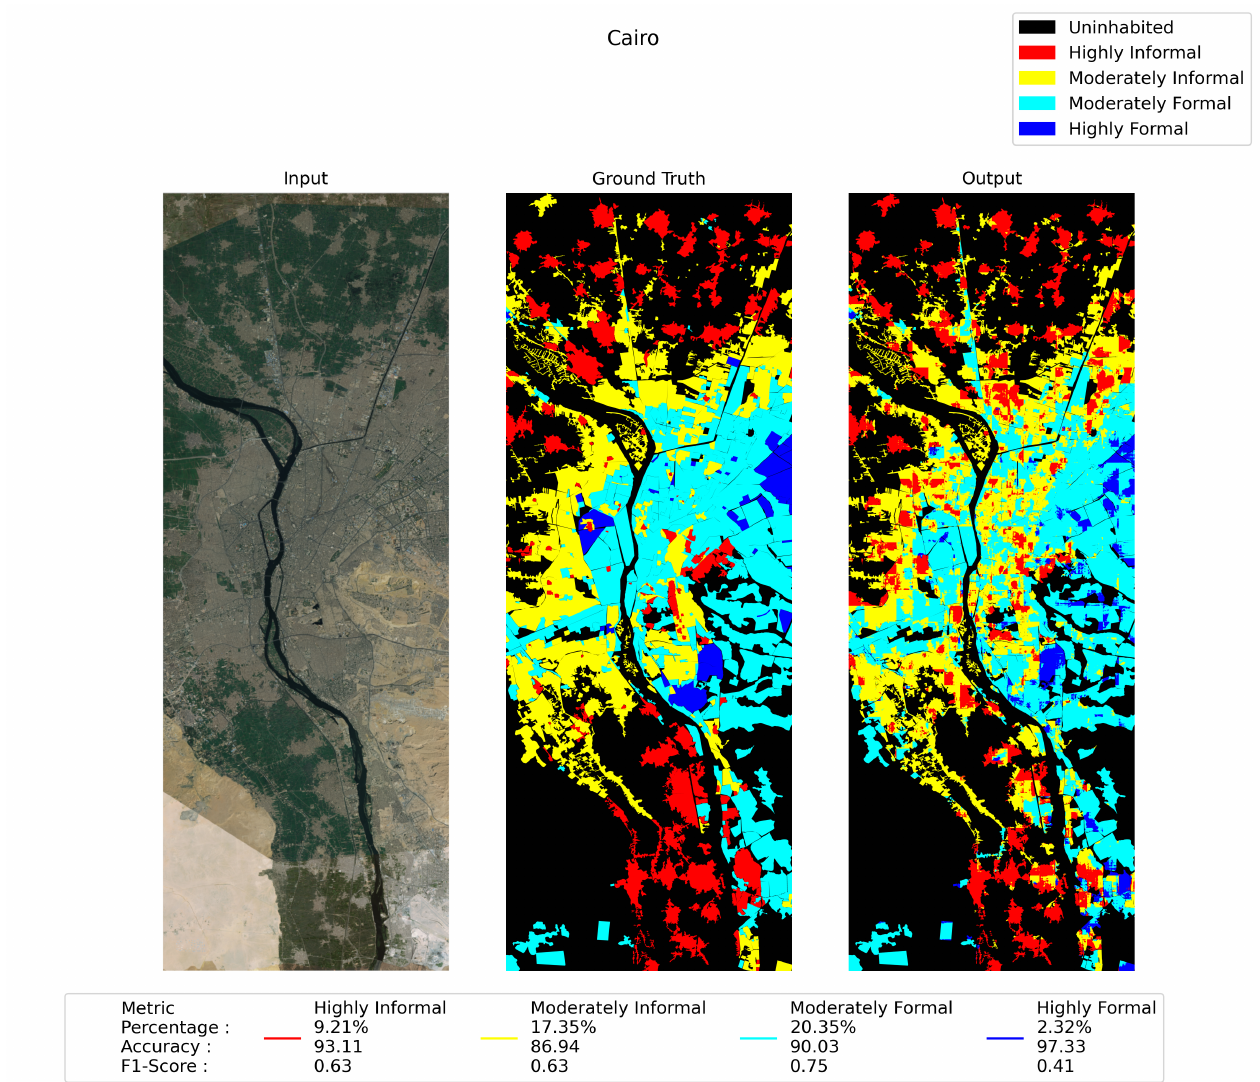
Figure 8. Test image, ground truth, and the test output—testing with 30% vertically middle part of